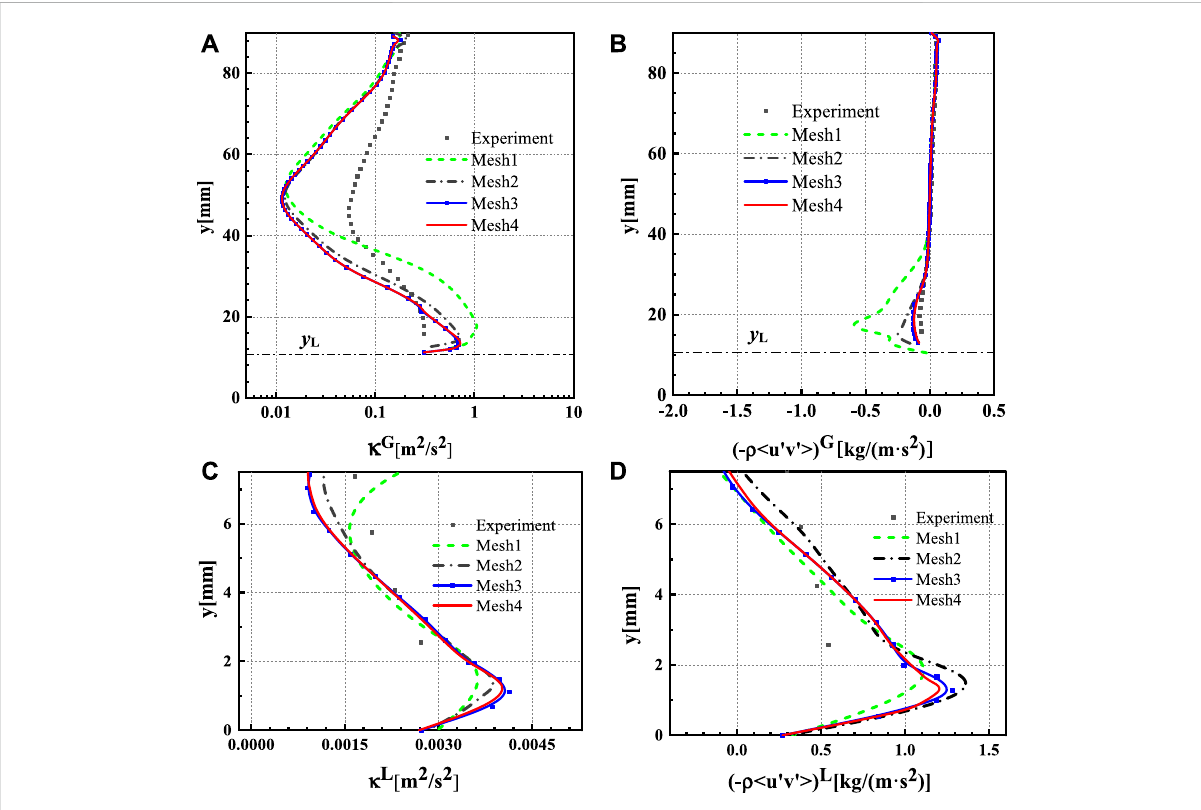
FIGURE 6 Turbulent kinetic energy ( κ ) and Reynolds stress component ( - ρ < u ’ v ’ > ) for four meshes at MP1, (A) turbulent kinetic energy distribution of the gas phase, (B) Reynolds stress component distribution of the gas phase, (C) turbulent kinetic energy distribution of the liquid phase, (D) Reynolds stress component distribution of the liquid phase.